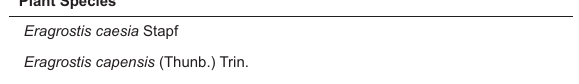
Eragrostis racemosa (Thunb.) Steud.